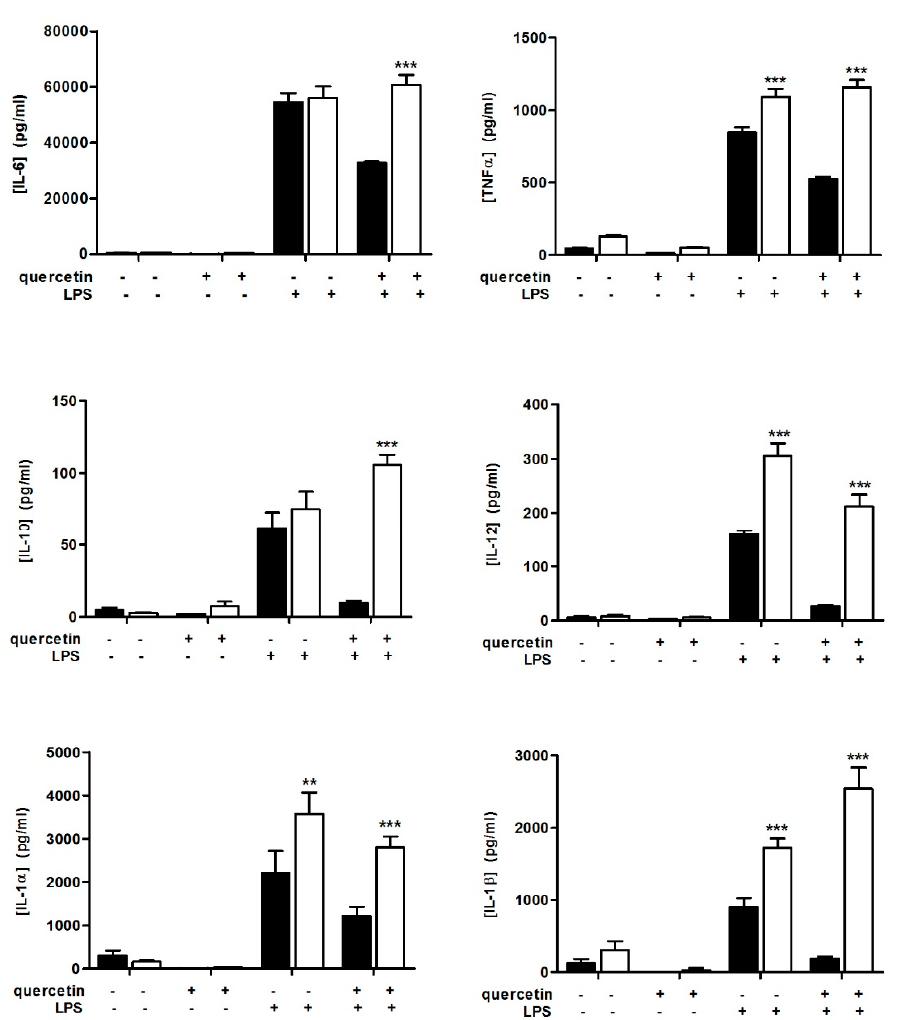
Figure 1. Quercetin reduces inflammatory cytokines secretion in wild-type (WT) dendritic cells (DCs). Bone marrow-derived DCs (BMDCs) were cultured from WT (black bars) and Slpi-KO (white bars) mice, treated with quercetin at day 5 and 7 and exposed to lipopolysaccharide (LPS). Secretion of cytokines was determined 24 h later by Multiplex assay. Bars represent mean concentration of interleukin-6 (IL-6), tumor necrosis factor alpha (TNF α ), interleukin-10 (IL-10), interleukin-12 (IL-12), interleukin-1 alpha (IL-1 α ) and interleukin-1 beta (IL-1 β ) ± SEM ( n = 4). *** p < 0.001, ** p < 0.01.